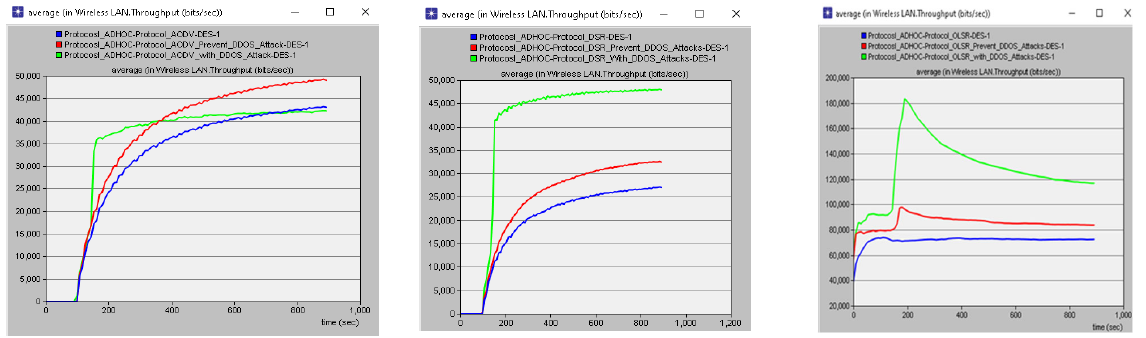
Fig. 4. Throughput for each protocol in different scenarios